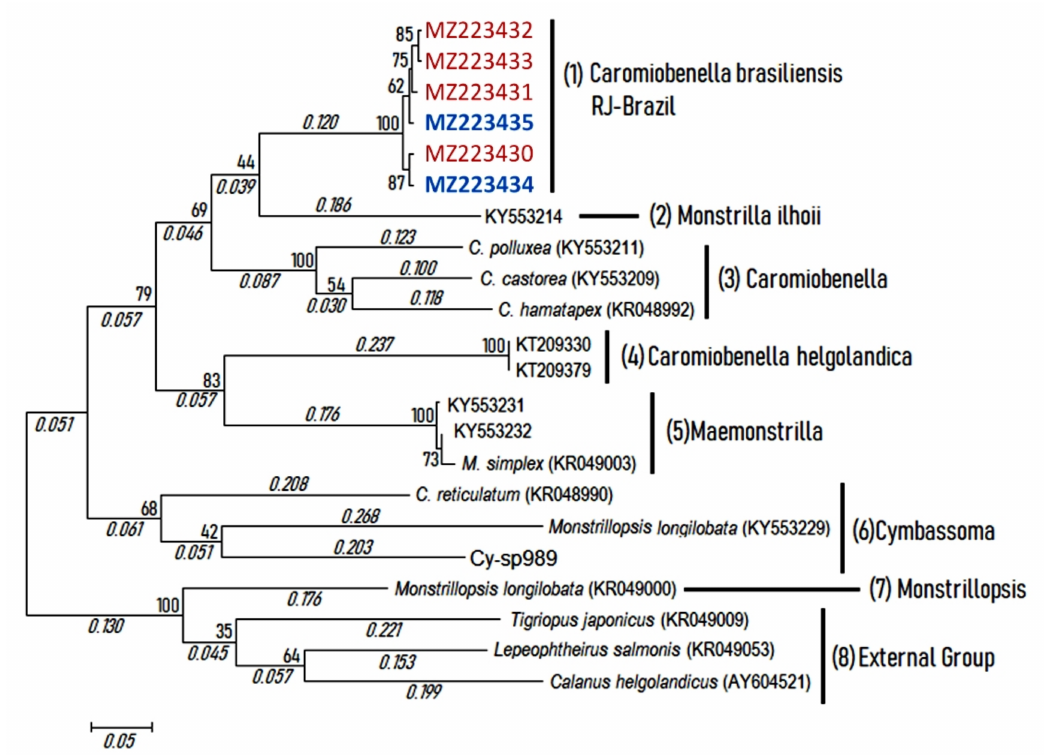
Figure 6. Maximum likelihood tree (Tamura-Nei) showing the position of Brazilian copepods from Rio de Janeiro coast in relation to other monstrilloid genera and species obtained from GenBank. Female Brazilian copepods in red and males in blue. See Table S1 for specific names and GenBank accession numbers for the partial sequences of C. brasiliensis used. Caromiobenella hamatapex and C. helgolandica appear as Monstrilla in